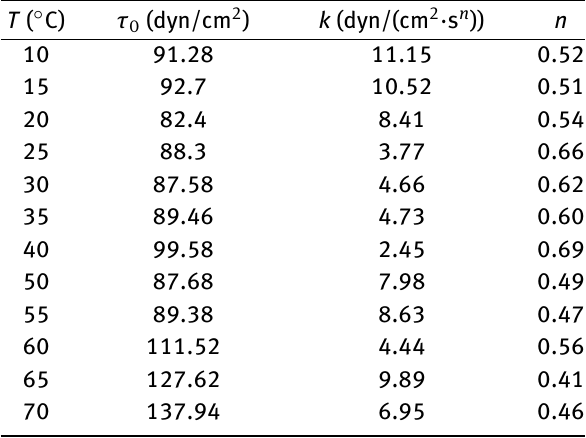
Table 1: Rheological parameters (estimated with FANN viscometer readings) in the temperature range of 10-70 ∘ C.